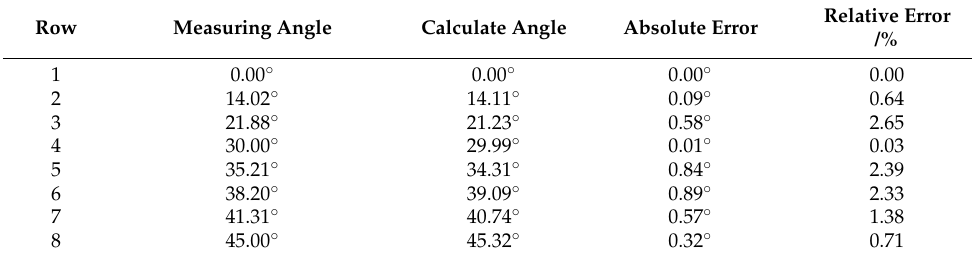
Table 5. The angle measurement